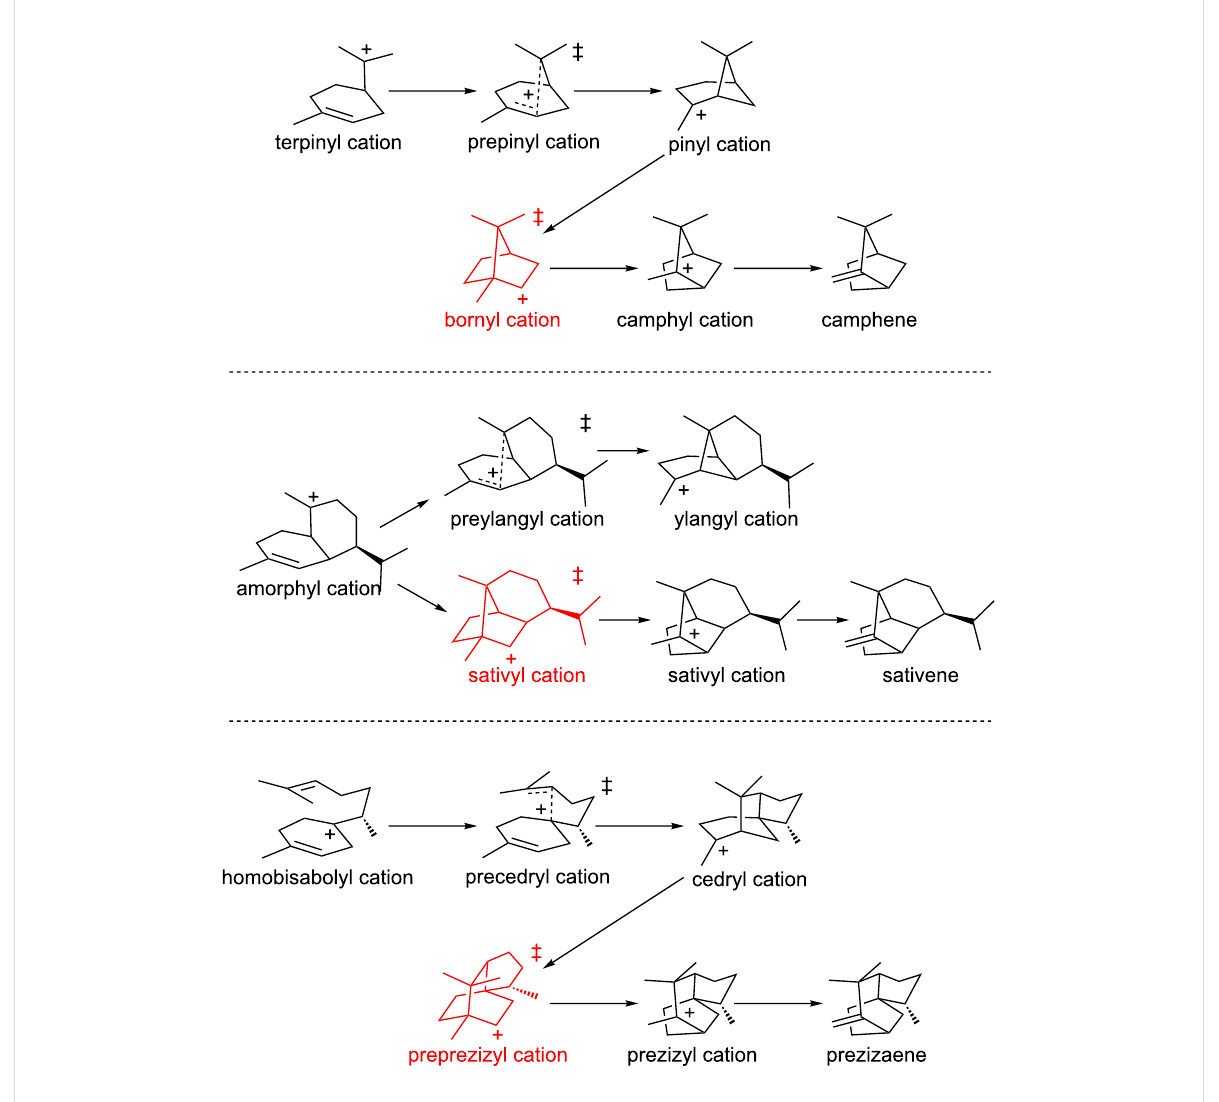
Figure 8: Carbocation rearrangements for which trajectory calculations were used to estimate lifetimes of secondary carbocations.